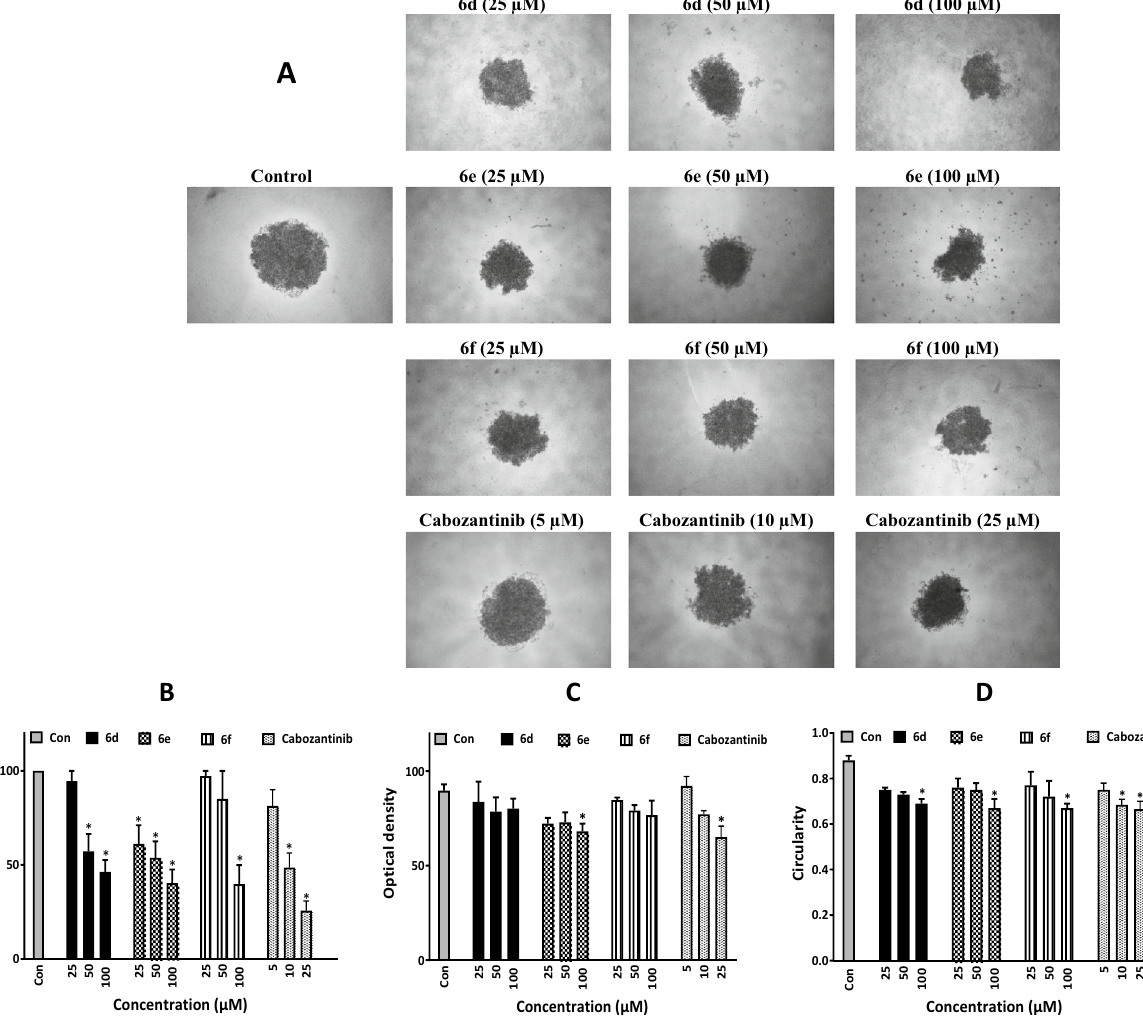
Figure 5. Inhibition of cancer cell growth in three-dimensional spheroid model. Spheroids of AsPc-1 cells were formed by liquid overlay technique in 96-well plates. ( A ) Representative images of spheroids treated with compounds 6d , 6e and 6f at the concentration of 25, 50, and 100 µM are shown . The images were prepared with Nikon NIS-Elements imaging software. ( B ) Growth inhibitory effects of compounds on AsPc-1 spheroids was measured by APH assay. ( C ) Optical density and ( D ) Circularity of 3D spheroids after the administrations of synthesized compounds were measured by ImageJ software. The positive controls cabozantinib and gemcitabine had observed IC 50 values of 8.6 ± 0.7 and 17.8 ± 6.8 µM, respectively. Data are presented as mean ± S.E.M. of at least 3 separate experiments; *The difference with control was statistically significant ( p <